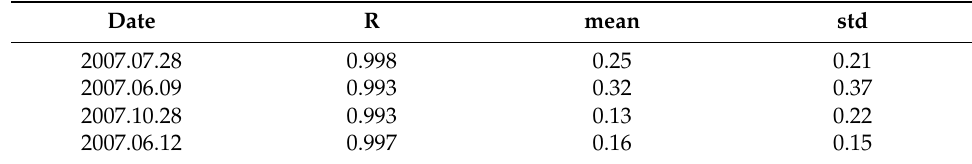
Table 2. Correlation coefficients (R) and absolute height differences (mean and standard deviation (std) in km) between ABLH retrieved by HM and CFM based on lidar data of four selected